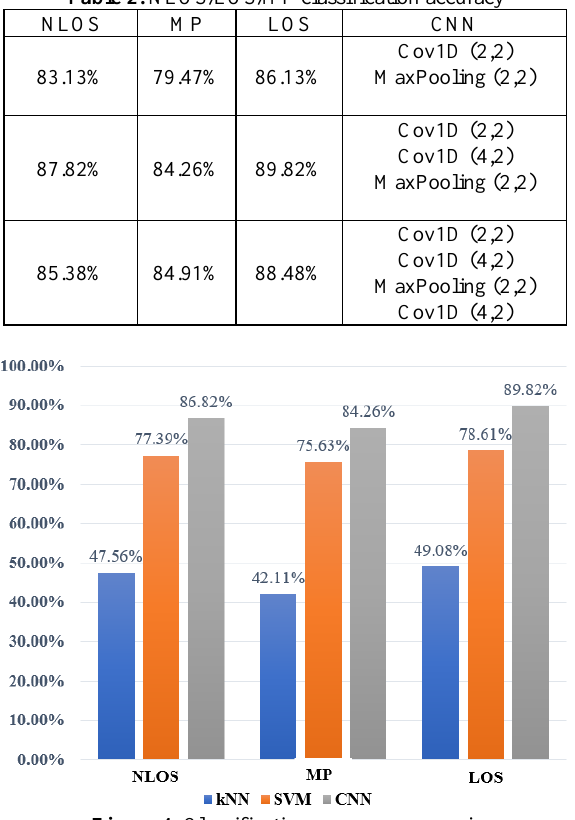
Table 2. NLOS/LOS/MP classification accuracy